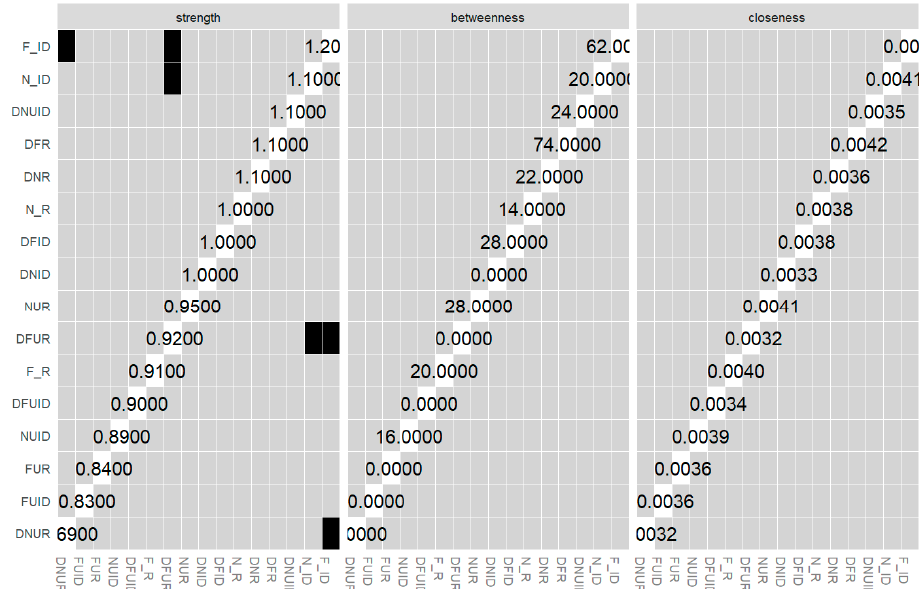
Figure 7. Relationship for the nodes of interest in the whole data set. Gray boxes indicate nodes or edges that do not differ significantly from one another, and black boxes represent nodes or edges that do differ significantly from one another. White boxes in the centrality plot show the value of node strength.